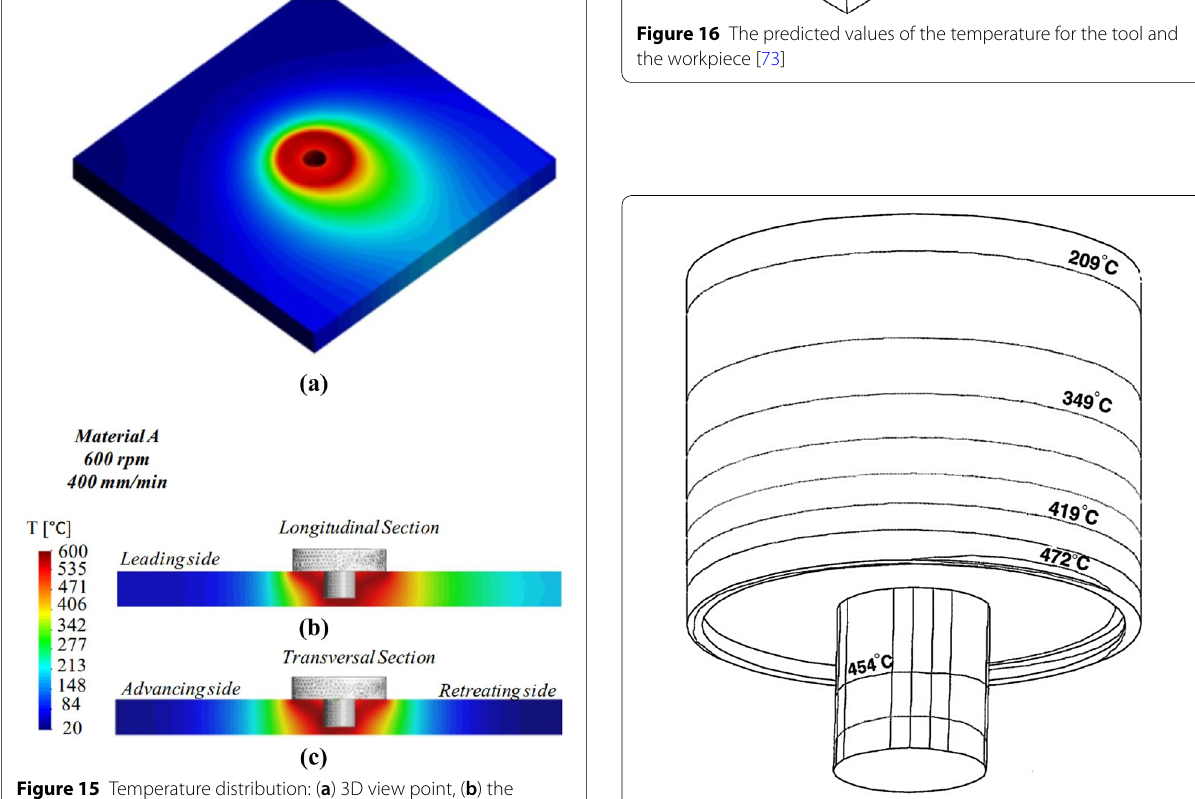
Figure 17 Temperature values at the tool interfaces